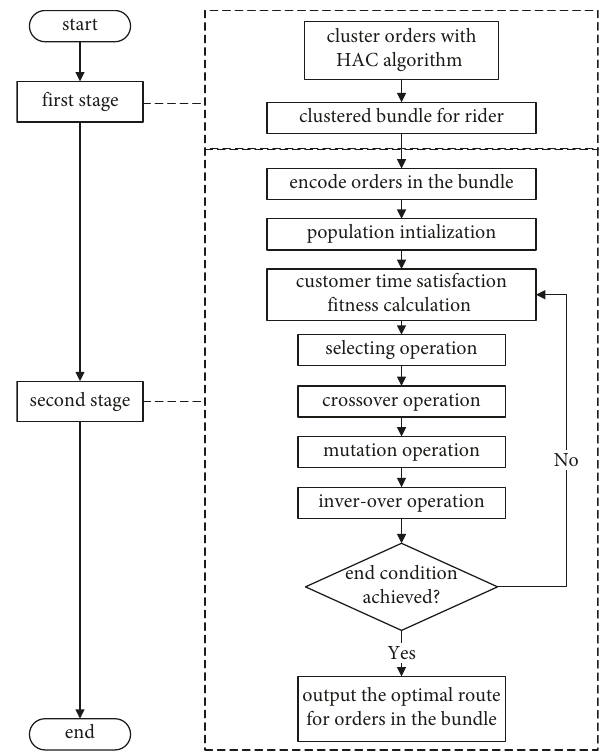
Figure 3: Two-stage solution design flowchart on HAC clustering and GA route